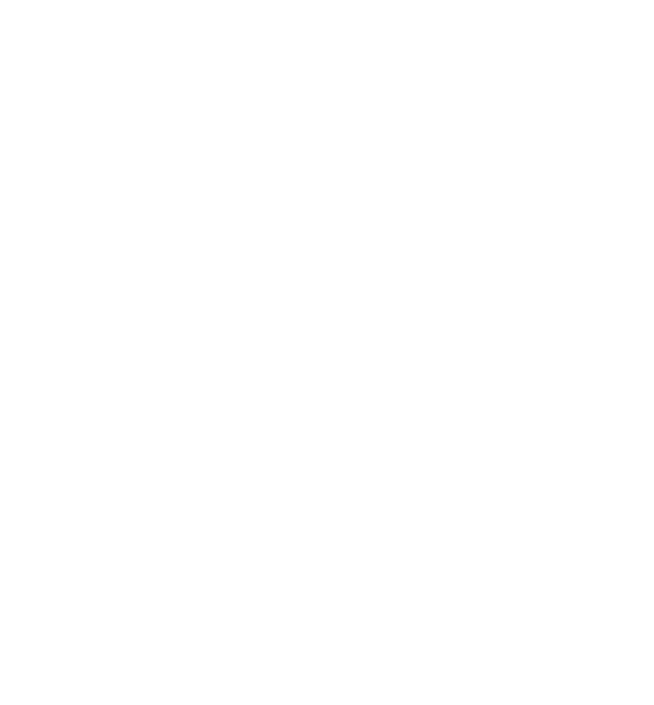
Figure 1. PossiblemechanismfortheformationofCDsusingabottom-upapproach. Adaptedfrom[50,51].